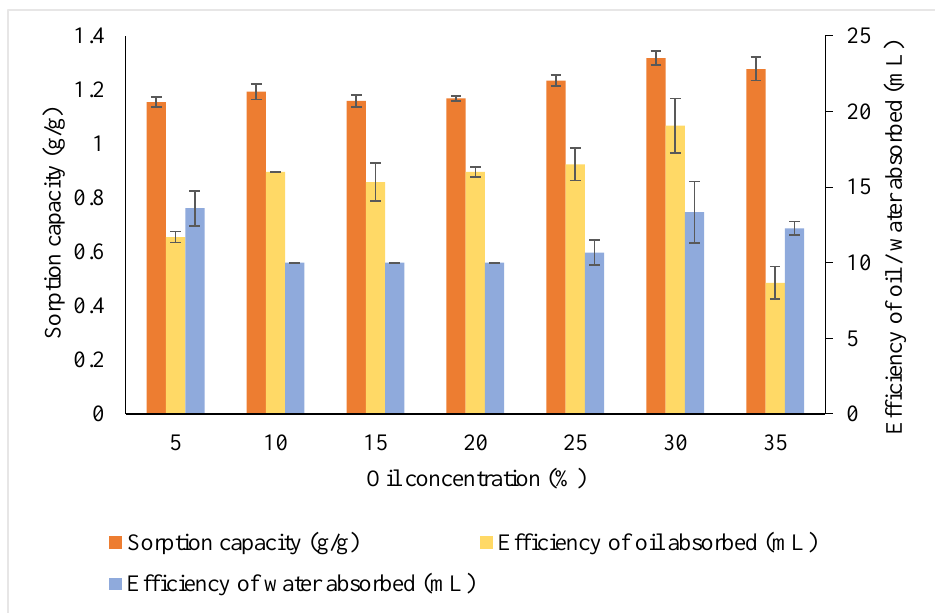
Figure 9. Effects of varying oil concentrations ( v / v )% on sorption capacity and oil/water absorption efficiency. Error bars indicates SD for the three replicates.